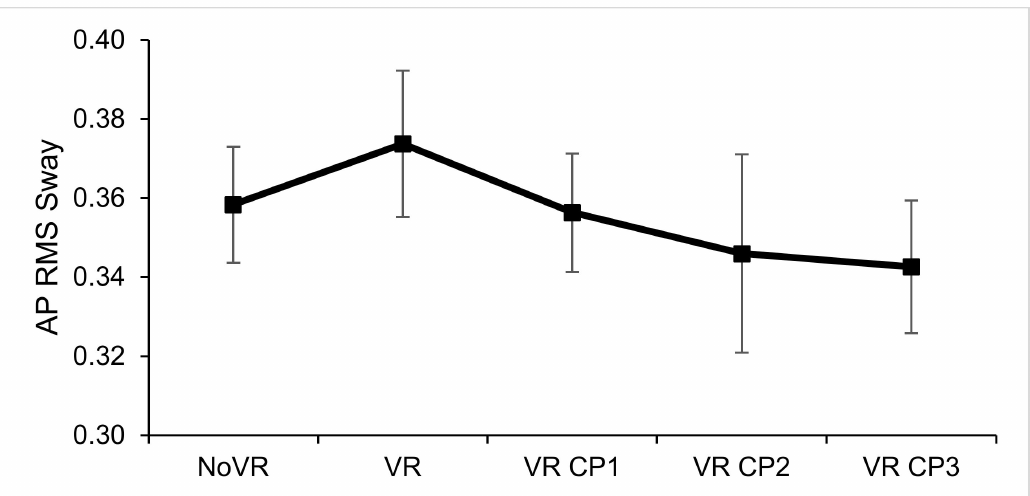
Figure 5. Anterior posterior root mean square (AP RMS) sway (cm) during upright bilateral stance with no virtual reality (NoVR), with virtual reality (VR), first trial in virtual environment with room walls closing in (VR CP1), second trial (VR CP2), and third trial (VR CP3).